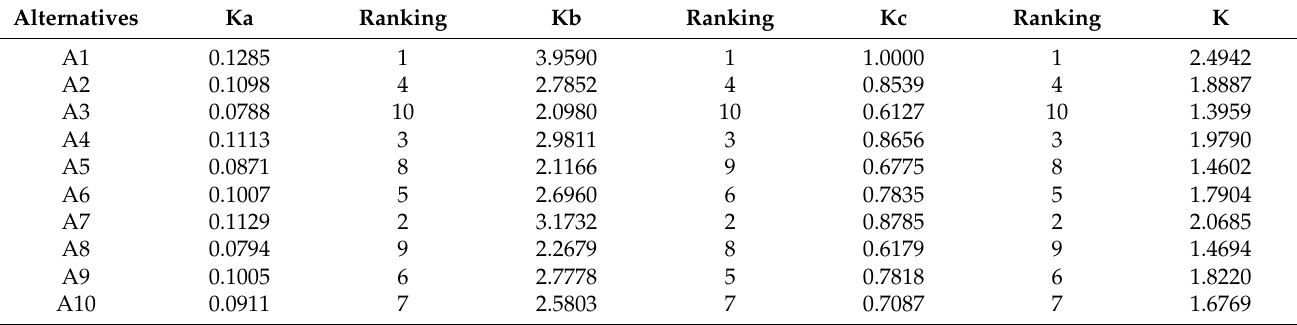
Table 4. Final aggregation and